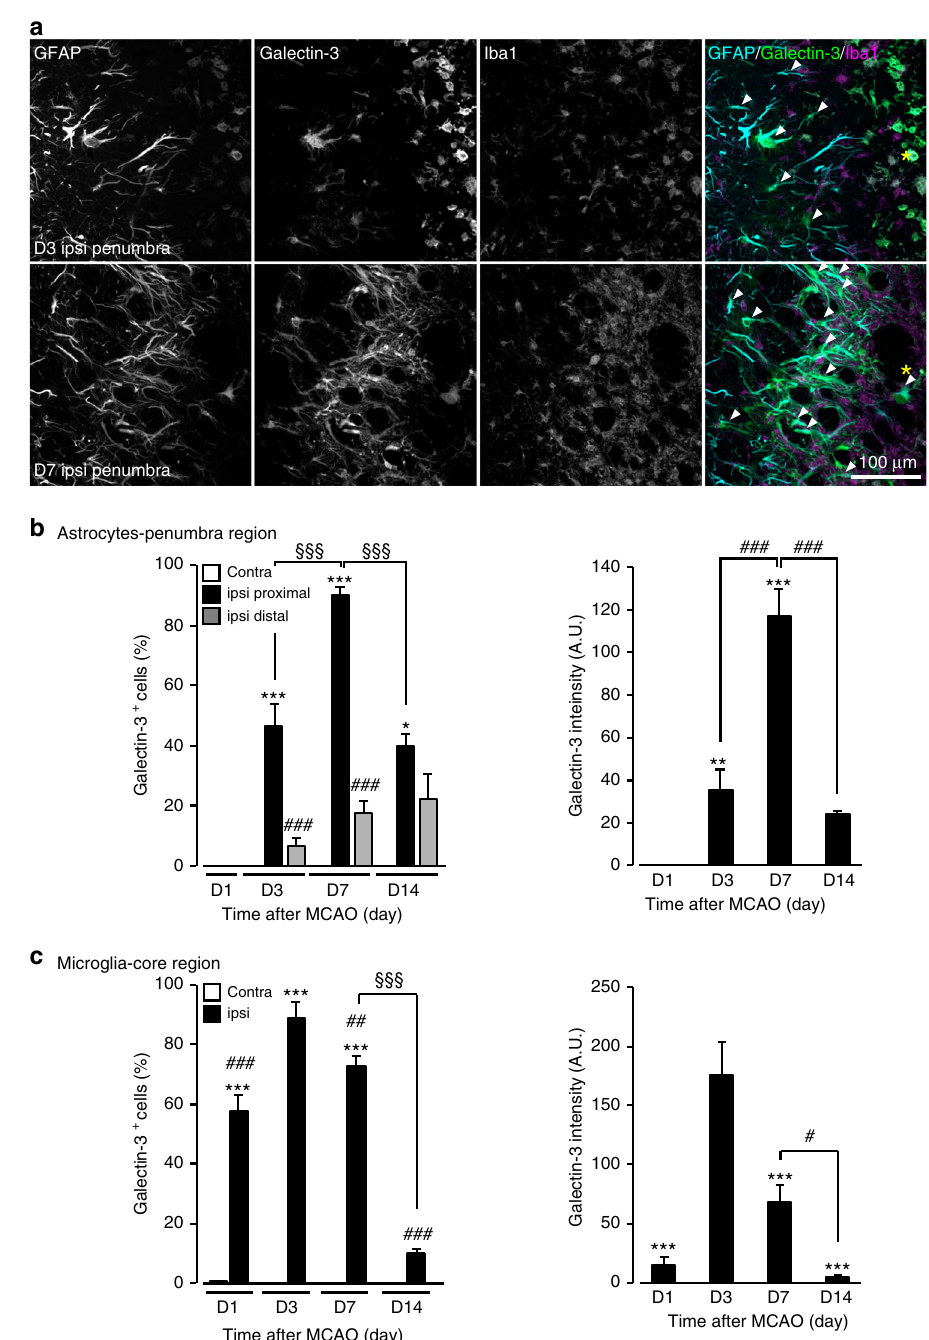
Fig. 4 Spatiotemporal differences in Galectin-3 between astrocytes and microglia. a Representative images showing IHC staining for GFAP, Iba1, and Galectin-3 in the ischemic penumbra at 3 and 7 days after MCAO. Arrowheads indicate Galectin-3 in astrocytes. Asterisks indicate the ischemic core ( n = 5 mice). Thirteen images per z-stack image (0.5 µ m step). b Left , quanti fi cation of spatiotemporal pro fi le of Galectin-3 + astrocytic population (3PGDH + cells) after MCAO ( n = 4, 4, 5, 15, 15, 15, 4, 12, 12, 4, 12, 12 fi elds, 3 – 5 mice, * P < 0.05, *** P < 0.001 vs. contra (corresponding day), ### P < 0.001 ipsi proximal vs. ipsi distal, §§§ P < 0.001 vs. ipsi proxymal D7, one-way ANOVA ( P < 0.0001) with Tukey ’ s multiple comparison test). Right , quanti fi cation of spatiotemporal pro fi le of Galectin-3 immunoreactivity mean intensity in 3PGDH + astrocytes in the ipsilateral striatum after MCAO ( n = 30, 51, 208, 76 cells, 3 – 5 mice, ** P < 0.01, *** P < 0.001 vs. D1, ### P < 0.001 vs. D7, one-way ANOVA ( P < 0.0001) with Tukey ’ s multiple comparison test). c Left , quanti fi cation of mean intensity of Galectin-3 immunoreactivity in Iba1 + microglia after MCAO ( n = 12, 12, 15, 15, 10, 14, 10, 15 fi elds, 4 – 5 mice, *** P < 0.001 vs. contra (corresponding day), ## P < 0.01, ### P < 0.001 vs. ipsi D3, §§§ P < 0.001 vs. ipsi D7, one-way ANOVA ( P < 0.0001) with Tukey ’ s multiple comparison test). Right , quanti fi cation of Galectin-3 + microglia population (Iba1 + ) in the ipsilateral striatum after MCAO ( n = 12, 15, 14, 15 fi elds, 4 – 5 mice, *** P < 0.001 vs. D3, # P < 0.05 vs. D7, one-way ANOVA ( P < 0.0001) with Tukey ’ s multiple comparison test). Values represent means ±